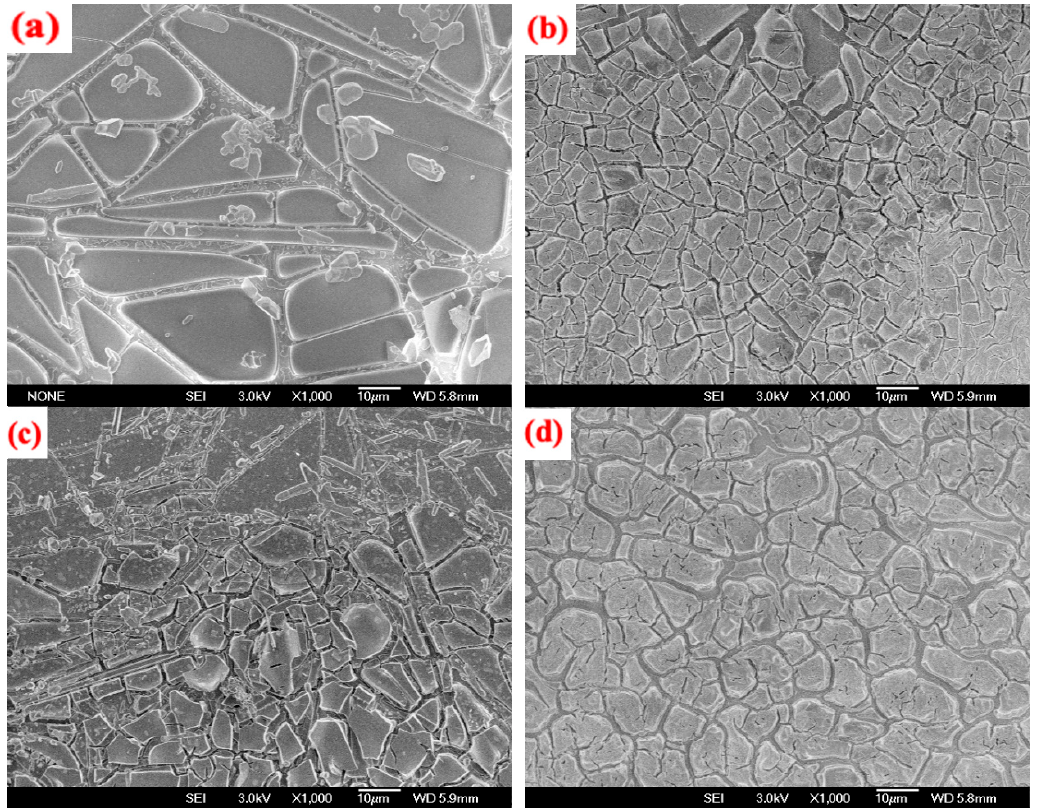
Figure 1. SEM images of synthesized samples (( a ) Undoped TiO 2 using dip coating ( b ) SnO 2 doped TiO 2 using spin coating, ( c ) Undoped TiO 2 using spin coating and ( d ) SnO 2 doped TiO 2 using dip coating).